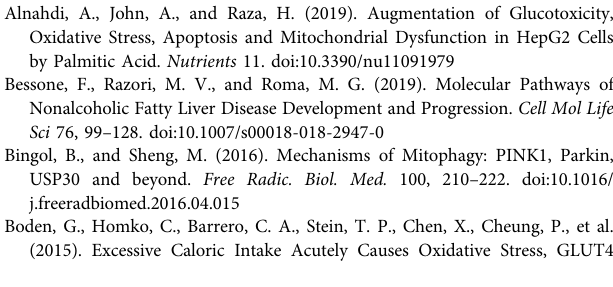
ANOVA). Figure Supplementary S2 | NAC could treat HFD-induced hepatic steatosis. (A) HEstainingofmiceliversectionindifferentgroups.Micewere fi rstlyfedwith8 weeks of HFD and then receive 4 weeks of NAC gavage; the scale bar is 50 μ m. (B) Serum TG, TC, and glucose level of different mice. (C) Immunoblot of PGC1a and SirT1 in hepatic tissue of model mice and quanti fi cation of Western blot (* p < 0.05; ** p < 0.01; all the data signi fi cance was analyzed by